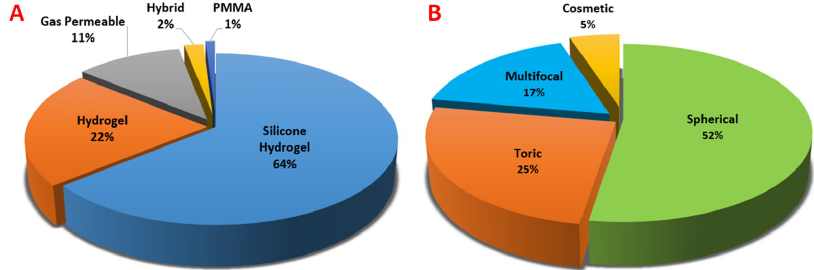
Figure 3. Contact lens use in 2017 by ( A ) materials class and ( B ) soft lens applications. Spherical lenses are, typically, used to correct myopia or hyperopia while toric lenses may help to correct astigmatism. Multifocal lenses can correct presbyopia and cosmetic lenses are designed to change the eye color with no particular medical purpose. Adapted with permission of Contact Lens Spectrum [49].